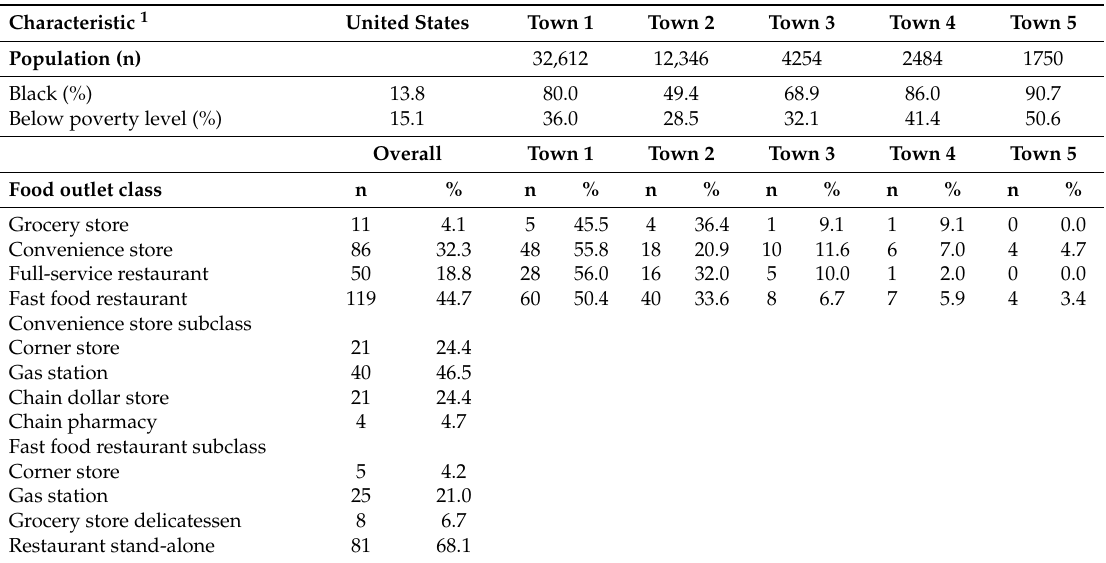
Table 1. Population characteristics and food outlet frequencies of the Lower Mississippi Delta towns (n =